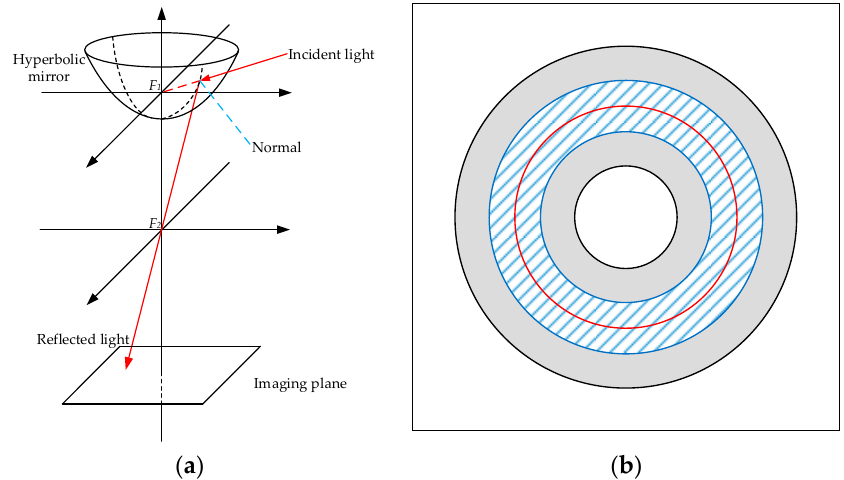
Figure 2. Simplified model of panoramic vision system and imaging plane: ( a ) simplified model of panoramic vision system including hyperbolic mirror and image plane; and ( b ) imaging plane. The red circle is horizon circle. In the SL-ALV algorithm, the landmarks located in the blue shaded area are selected as the input while the landmarks located in the grey area are removed. The white parts denote the invalid areas in the panoramic image.